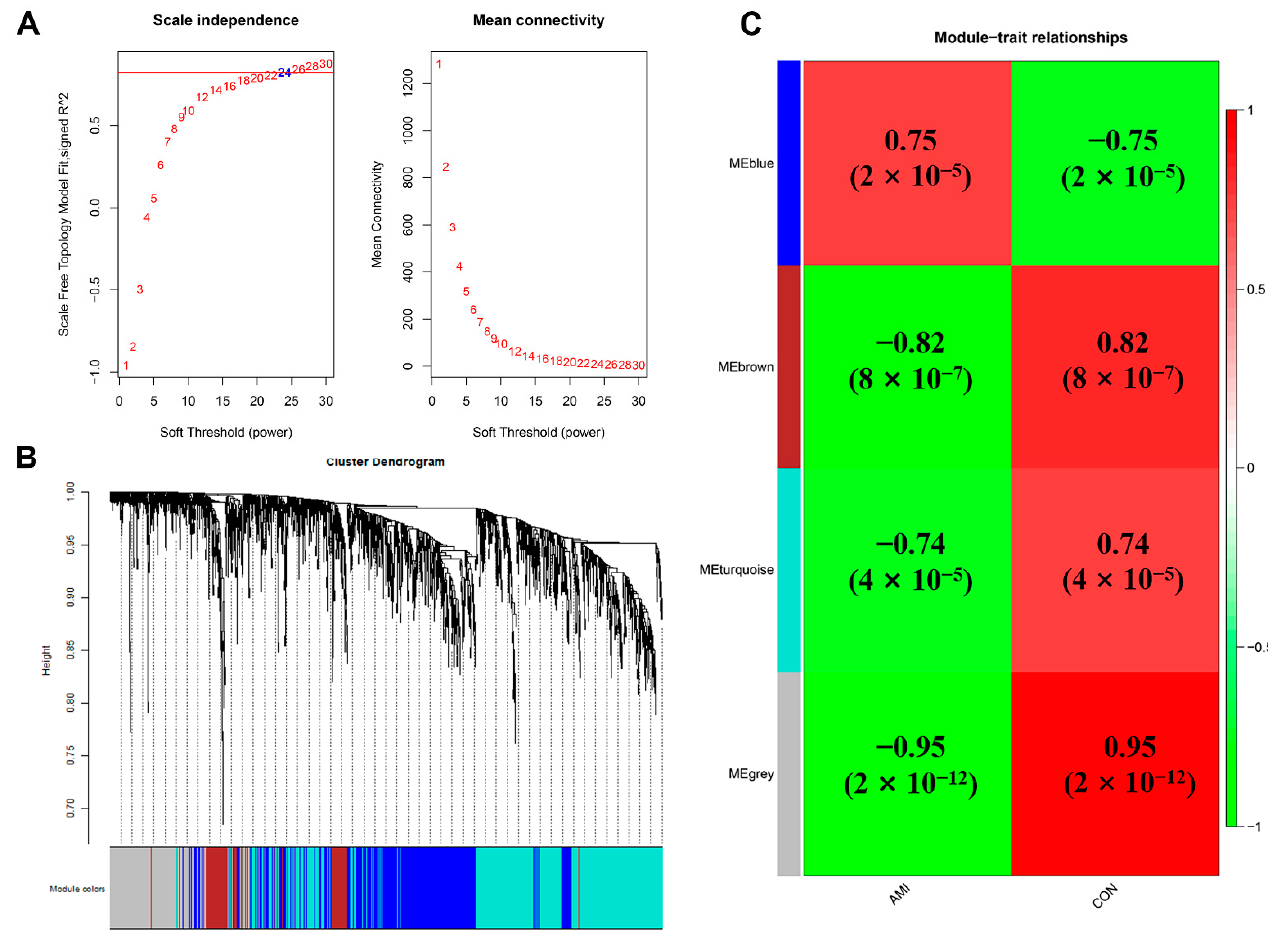
Figure 3. WGCNA of DEGs. ( A ) Estimation of the soft thresholding value for a scale-free co-expression network. ( B ) Cluster dendrogram of all DEGs. ( C ) Correlation between each module and AMI patients or controls.